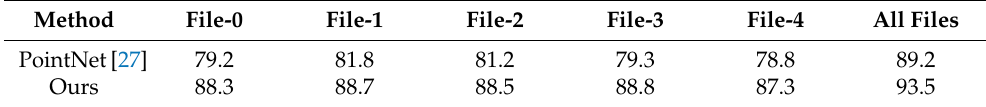
Table 8. Results on reduced training set